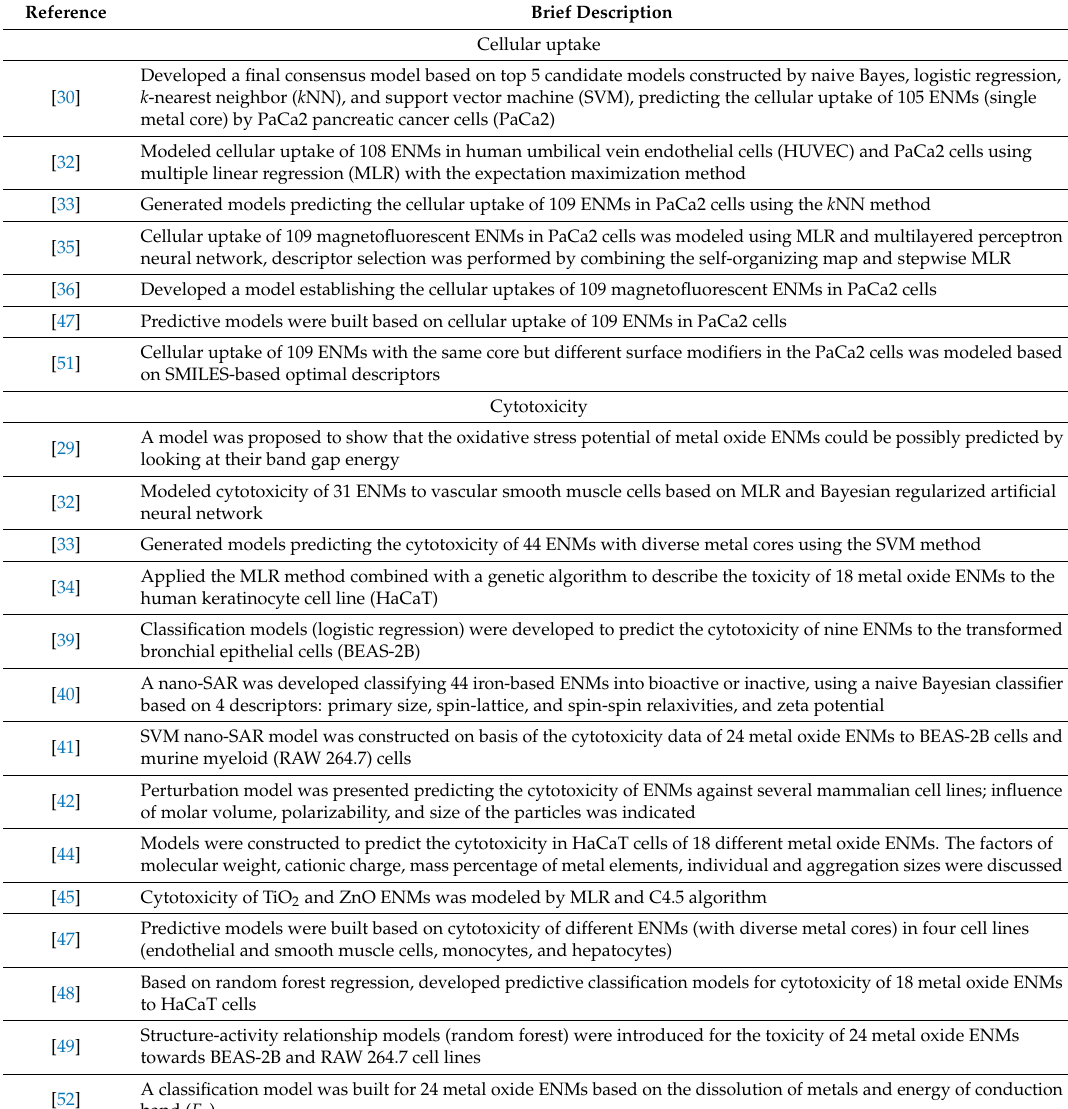
Table 1. Overview of the peer-reviewed literatures on nano-(Q)SARs, as generated by means of an advanced literature search in the Web of Science™ Core Collection on 22 February 2017, and supplemented with a manual collection of relevant publications not included in the search